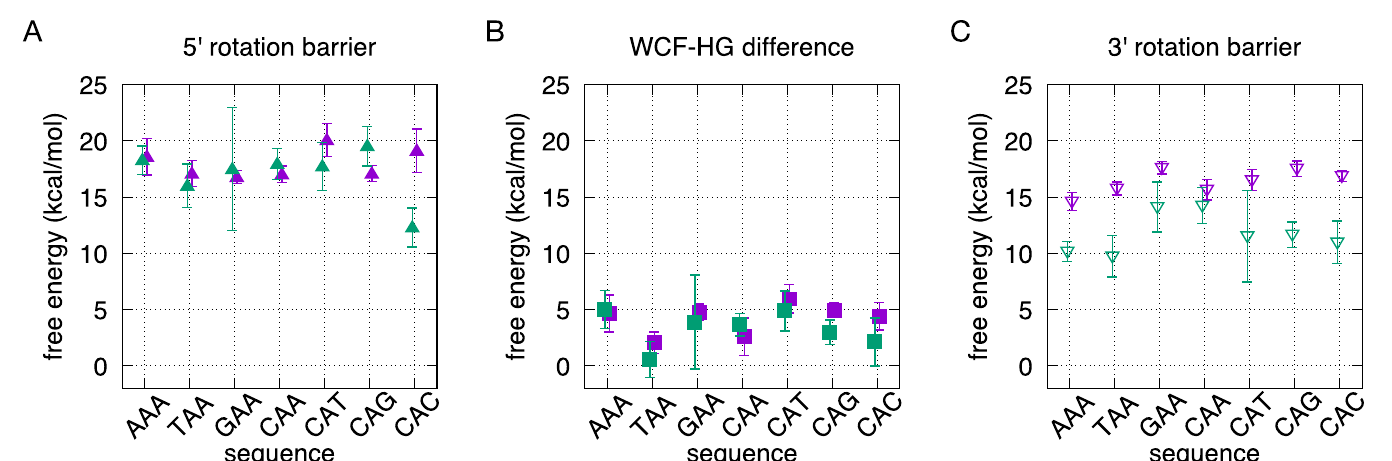
Fig 2. WCF-to-HG free-energy differences and barriers for the seven sequences. The sequences are shown in Fig A in S1 Text. The free-energy differences and barriers are extracted from the average free-energy profiles and error bars in Fig B in S1 Text. Inside paths are shown in purple and outside paths are shown in green. (A) Free- energy barriers via the rotation with the 6-ring of A16 pointing in the 5’ direction. (B) Free-energy differences. (C) Free-energy barriers via the rotation with the 6-ring of A16 pointing in the 3’ direction.